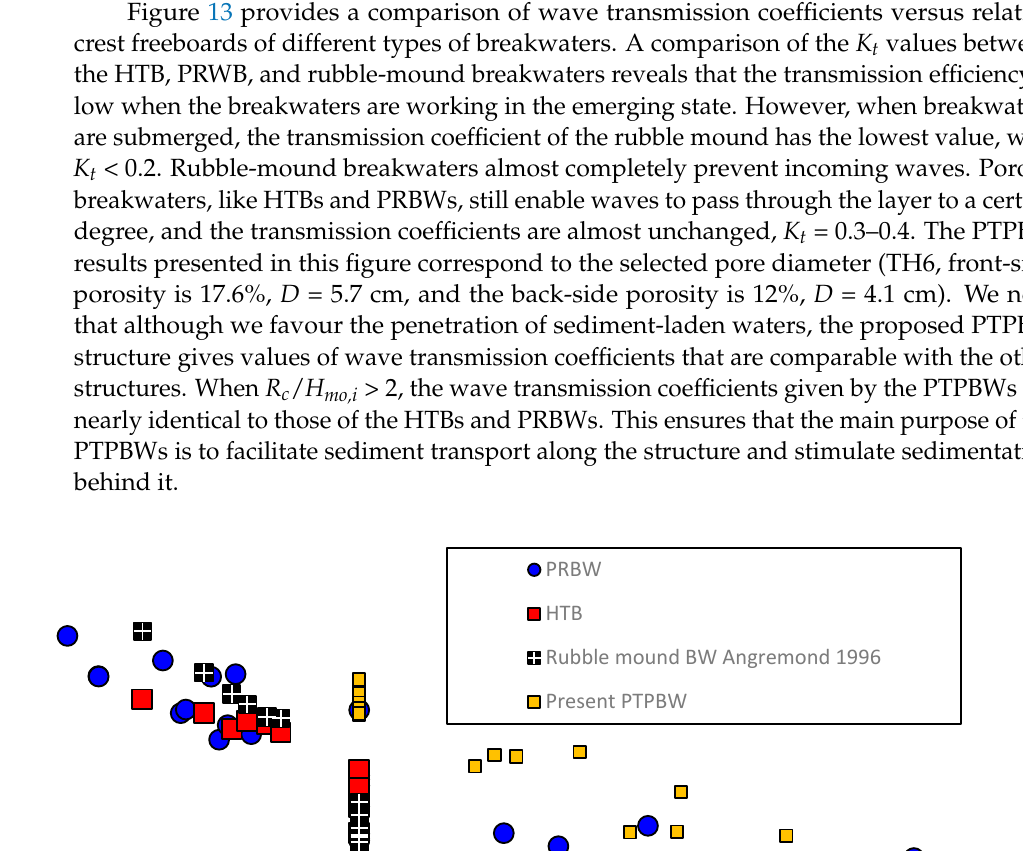
Figure 13. Wave transmission coefficients versus relative crest freeboards of different types of breakwaters: PRBW (Le Xuan Tu et al., 2020) [10], HTB (Le Xuan Tu et al., 2022) [11], rubble-mound BW (D’Angremeond, 1997) [5], and present PTPBW.